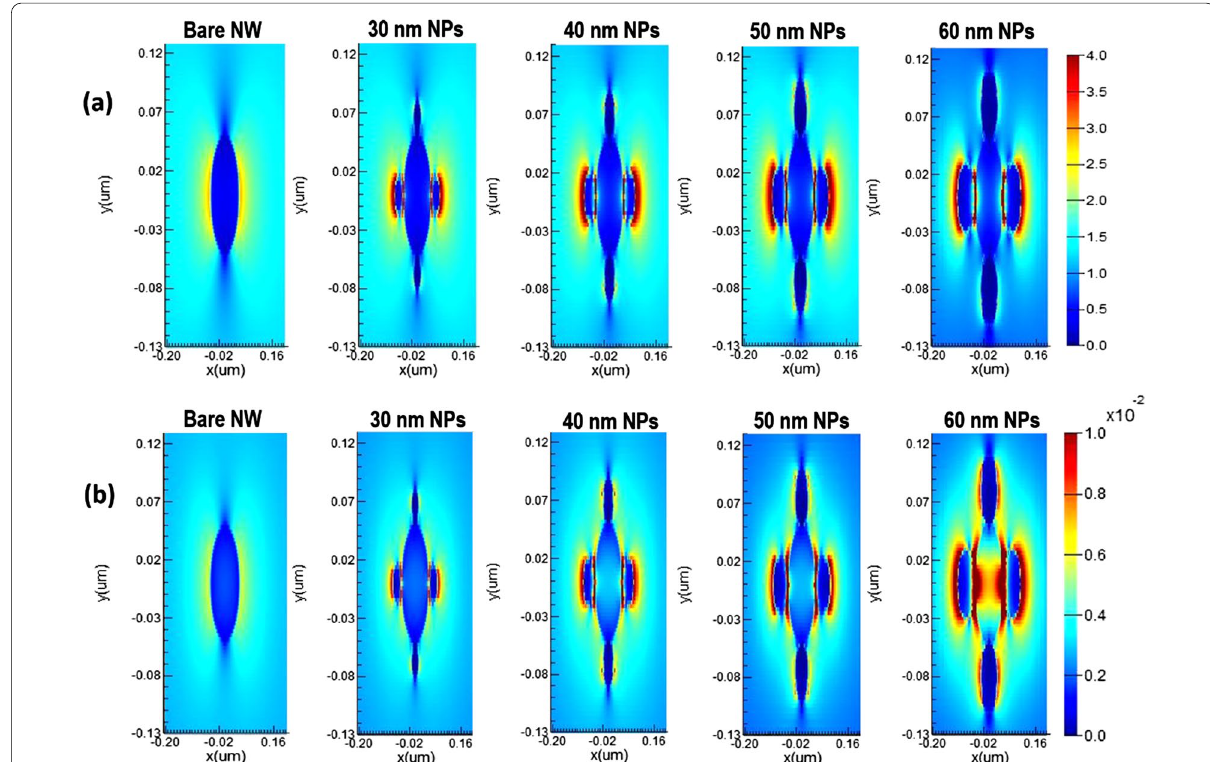
Fig. 4 Top view of the 2D light distribution; a the calculated absorbed power; b the GaAs nanowire after incorporation of the Au NPs of 30, 40, 50 and 60 nm diameter calculated by FDTD at the light wavelength of 800 nm compared to the bare GaAs